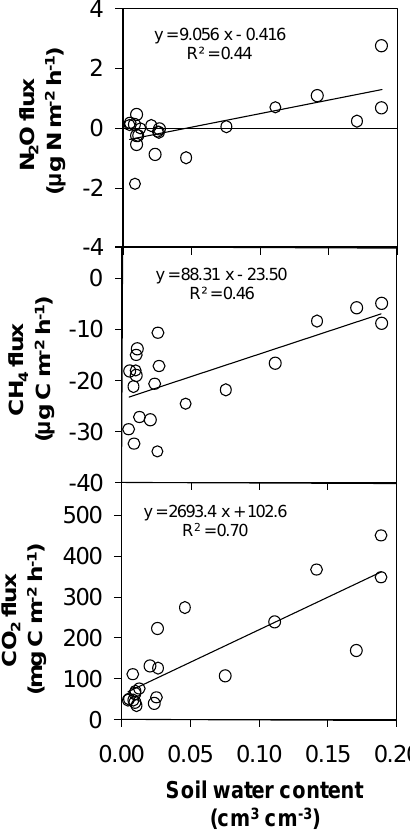
Fig. 6. The relationships between soil water content and CO 2 , CH 4 and N 2 O fluxes from savanna soils in the Douglas Daly re- gion. Each point is the average value from five replicate chambers as measured at woodland, young pasture and old pasture sites on seven occasions through a 14 month